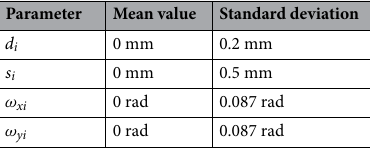
Table 4. Kinematics parameter values of joint